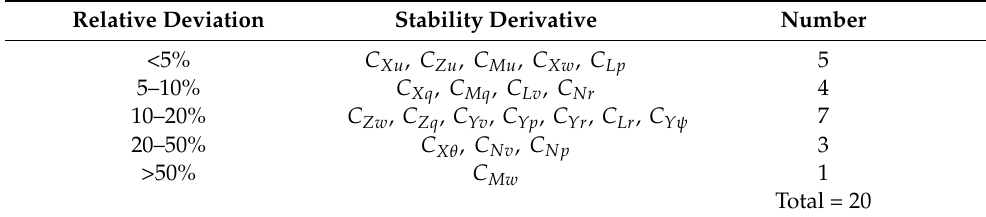
Table 37. Comparison of consistency of stability derivatives (landing).